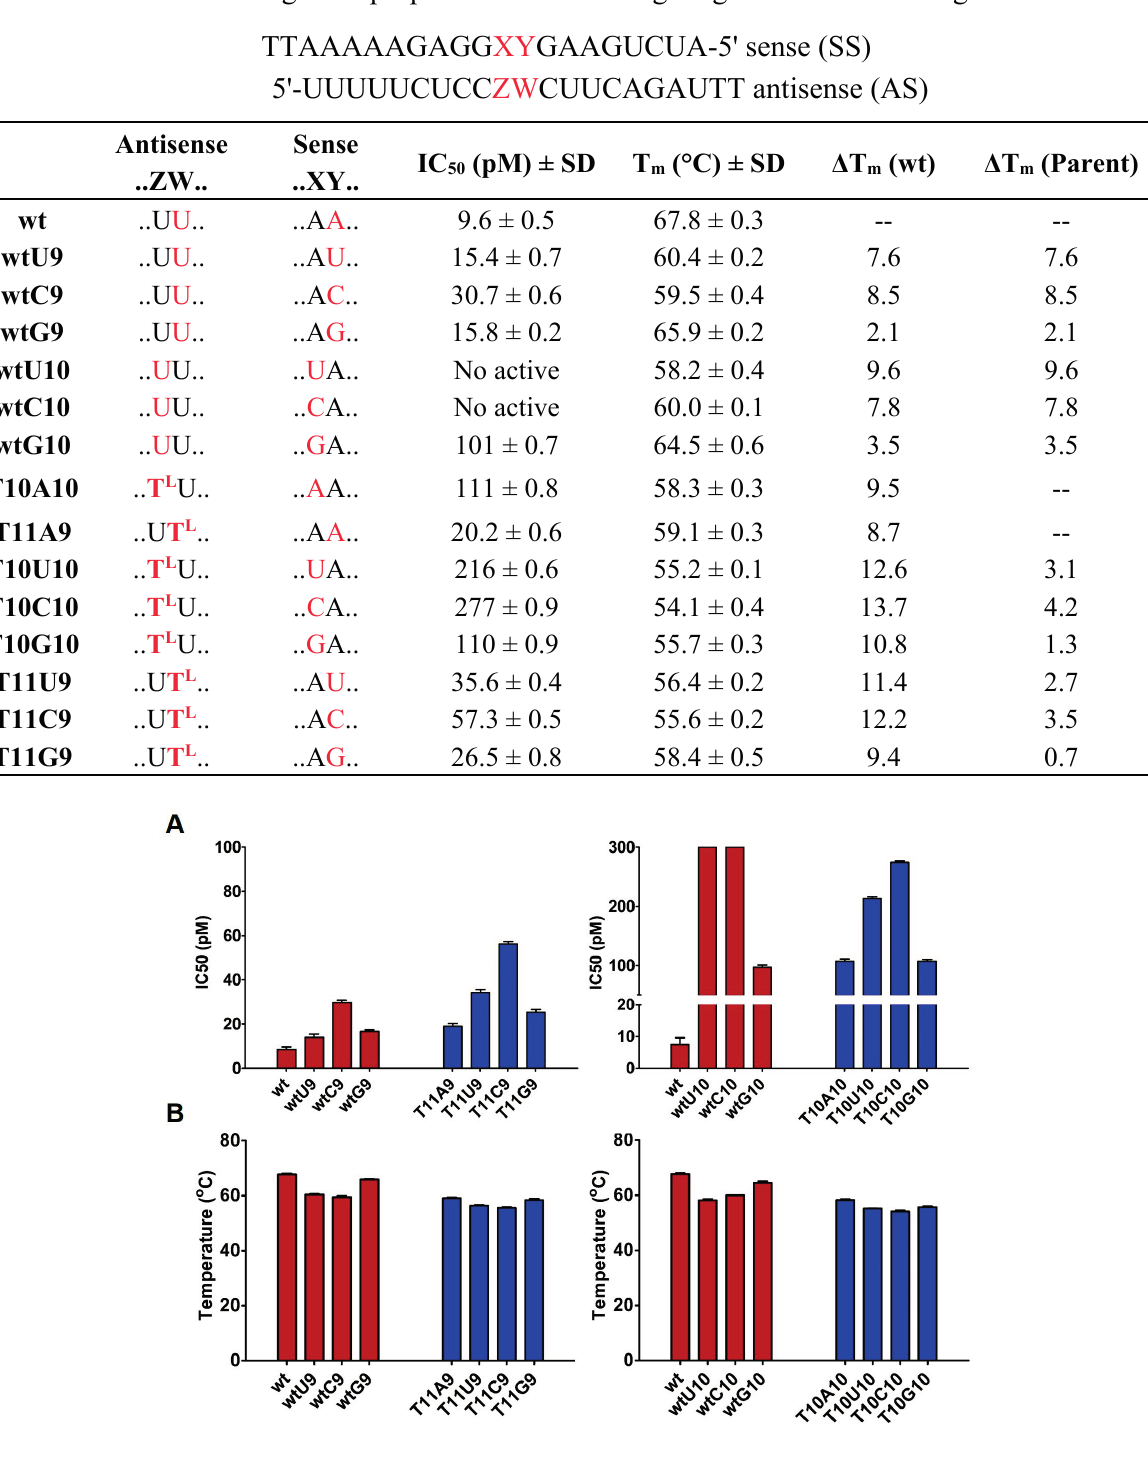
Table 1. Design and properties of siRNA targeting Renilla luciferase gene.